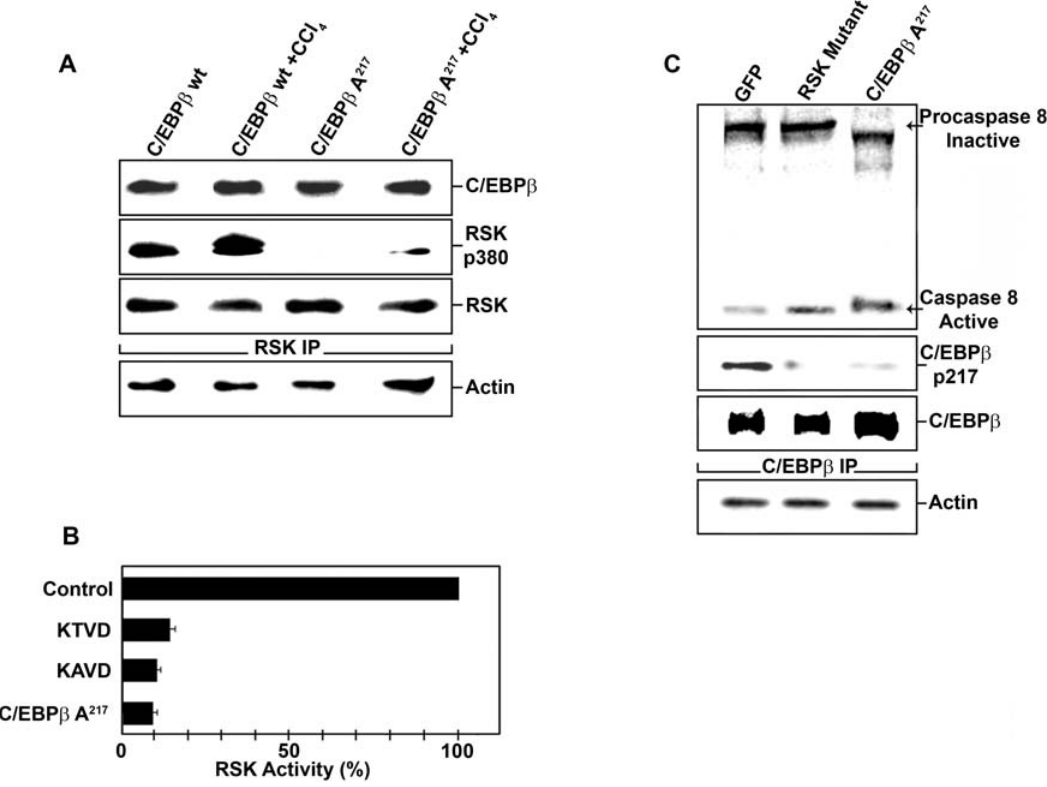
Figure 5. C/EBP b -Ala217 inhibits RSK activation in hepatic stellate cells. A. A phospho-RSK immunoblot was performed on RSK immunoprecipitates from protein lysates of purified HSC in an experiment conducted as described in (Fig. 1). Phosphorylated RSK (RSKp380)